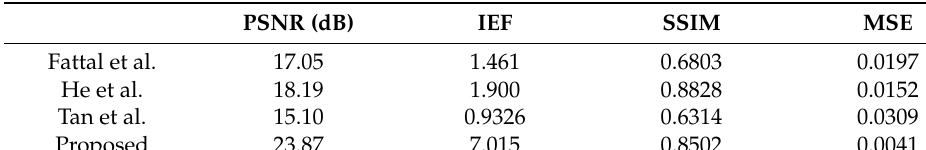
Table 6. Comparison result 3 using lower image from Figure 15.